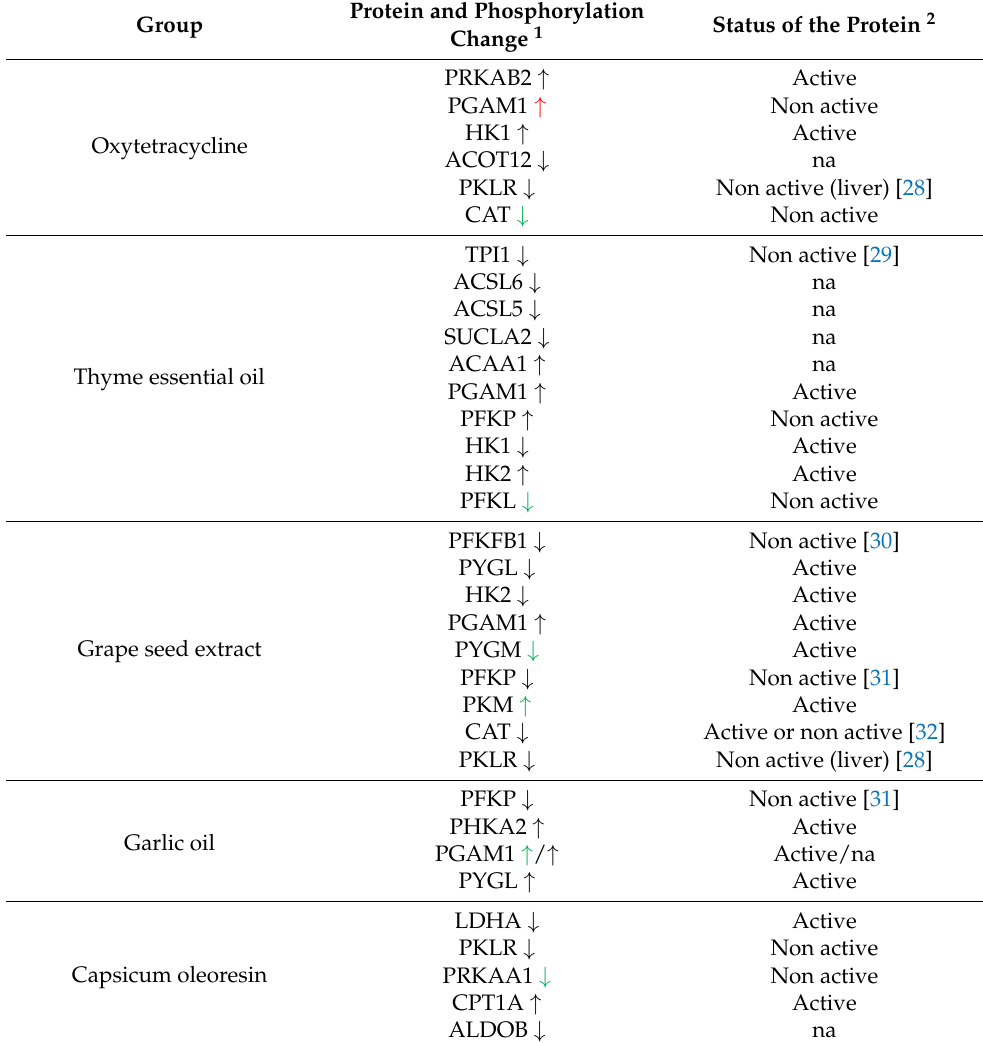
Table 3. Changes in the phosphorylation of significant metabolic peptides ( p ≤ 0.05) of HD11 cells infected with S. Enteritidis and treated with oxytetracycline or plant extracts.